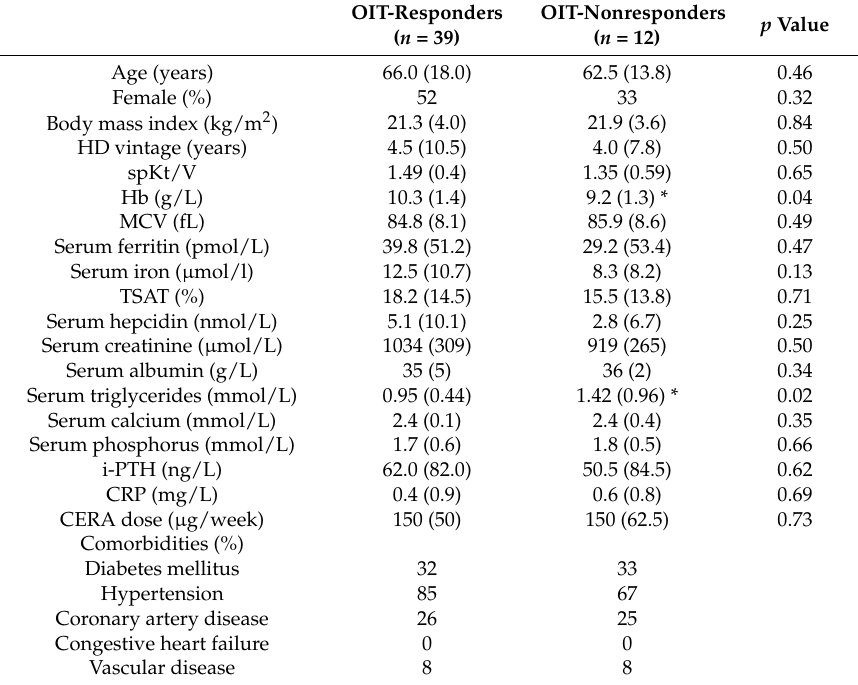
Table 1. Demographic and laboratory data in OIT-responders and